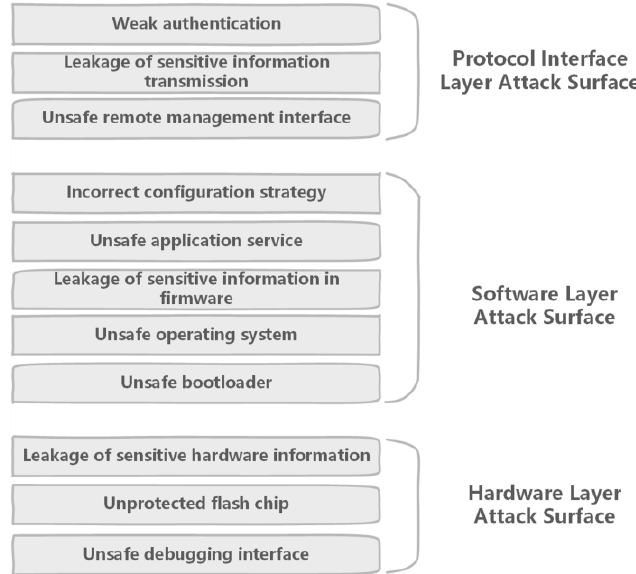
Figure 15. Attack surface of IoT device [88].